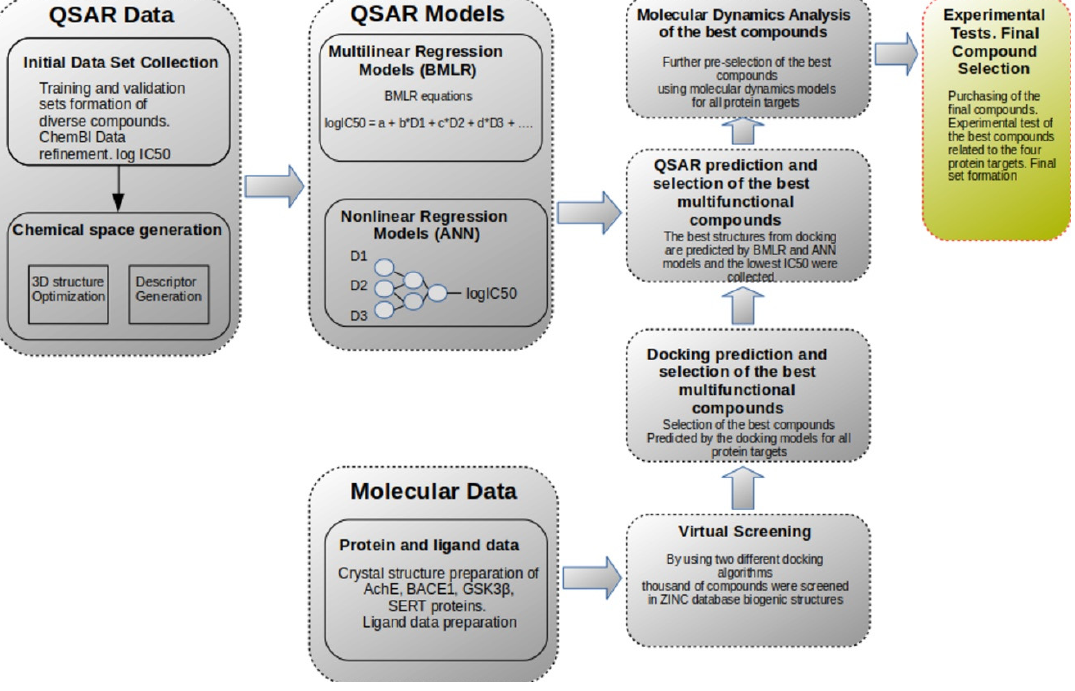
Table 1. Statistical parameters of the BMLR models for all four data sets.